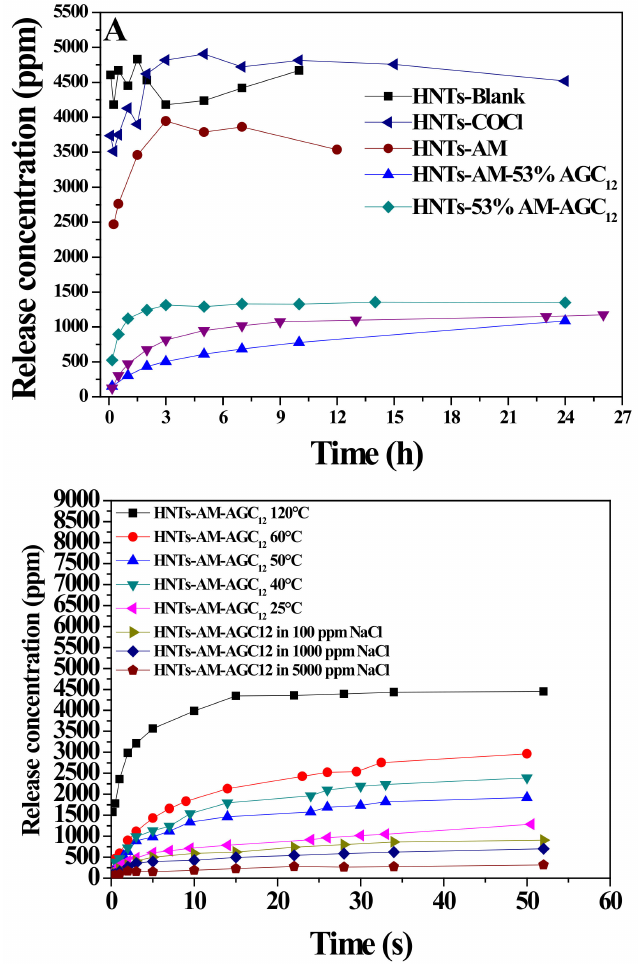
Figure 5. The release of methenamine during the aging of nanocontainers at different surrounding